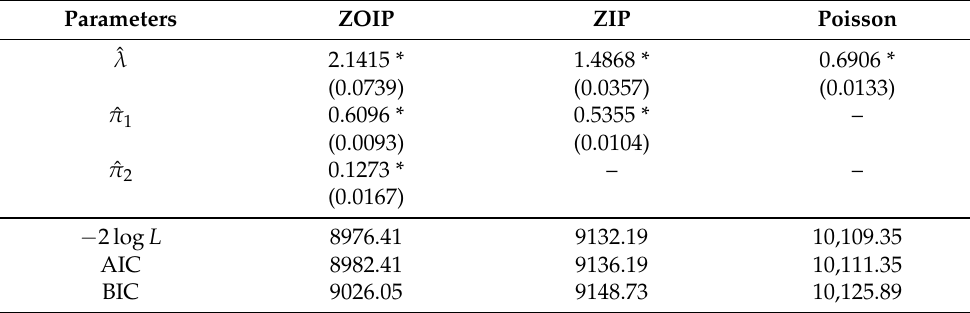
Table 10. Parameter estimates for sunburn